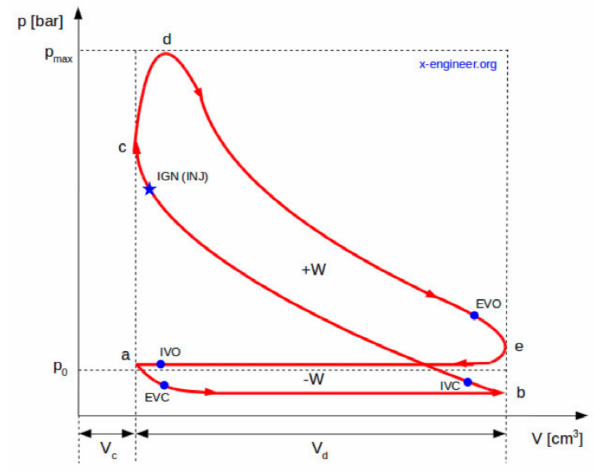
Figure 2. The supercharged indicated cycle.